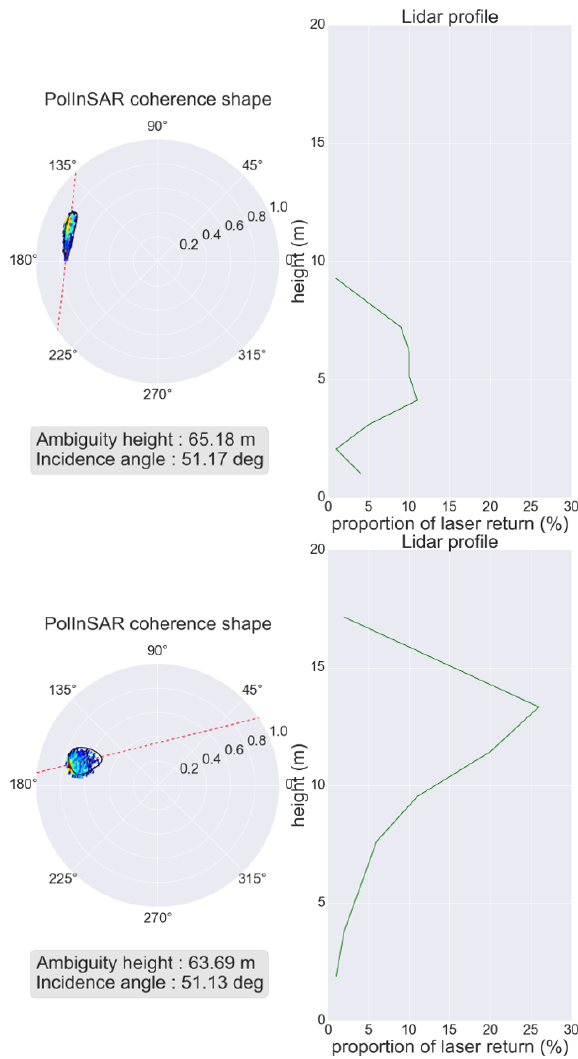
Figure 3. Example of coherence region associated with different vertical forest profiles: 9-m pine trees on the Top , 12-m spruce tress on the Bottom